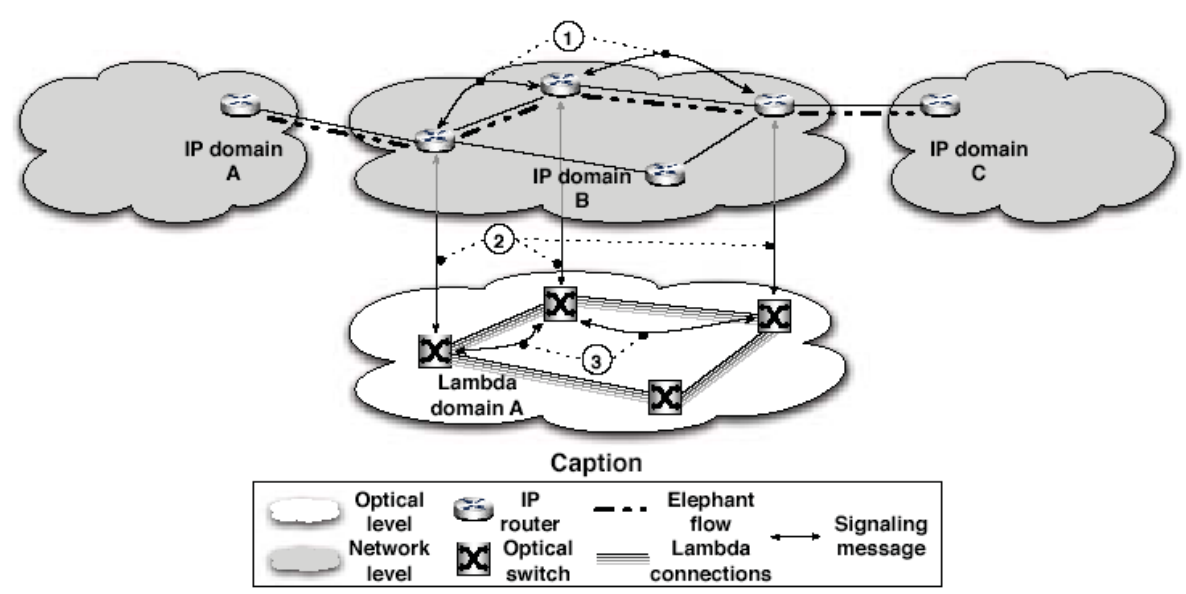
Figure 2. Architecture of a self-managed optical network. Extracted from